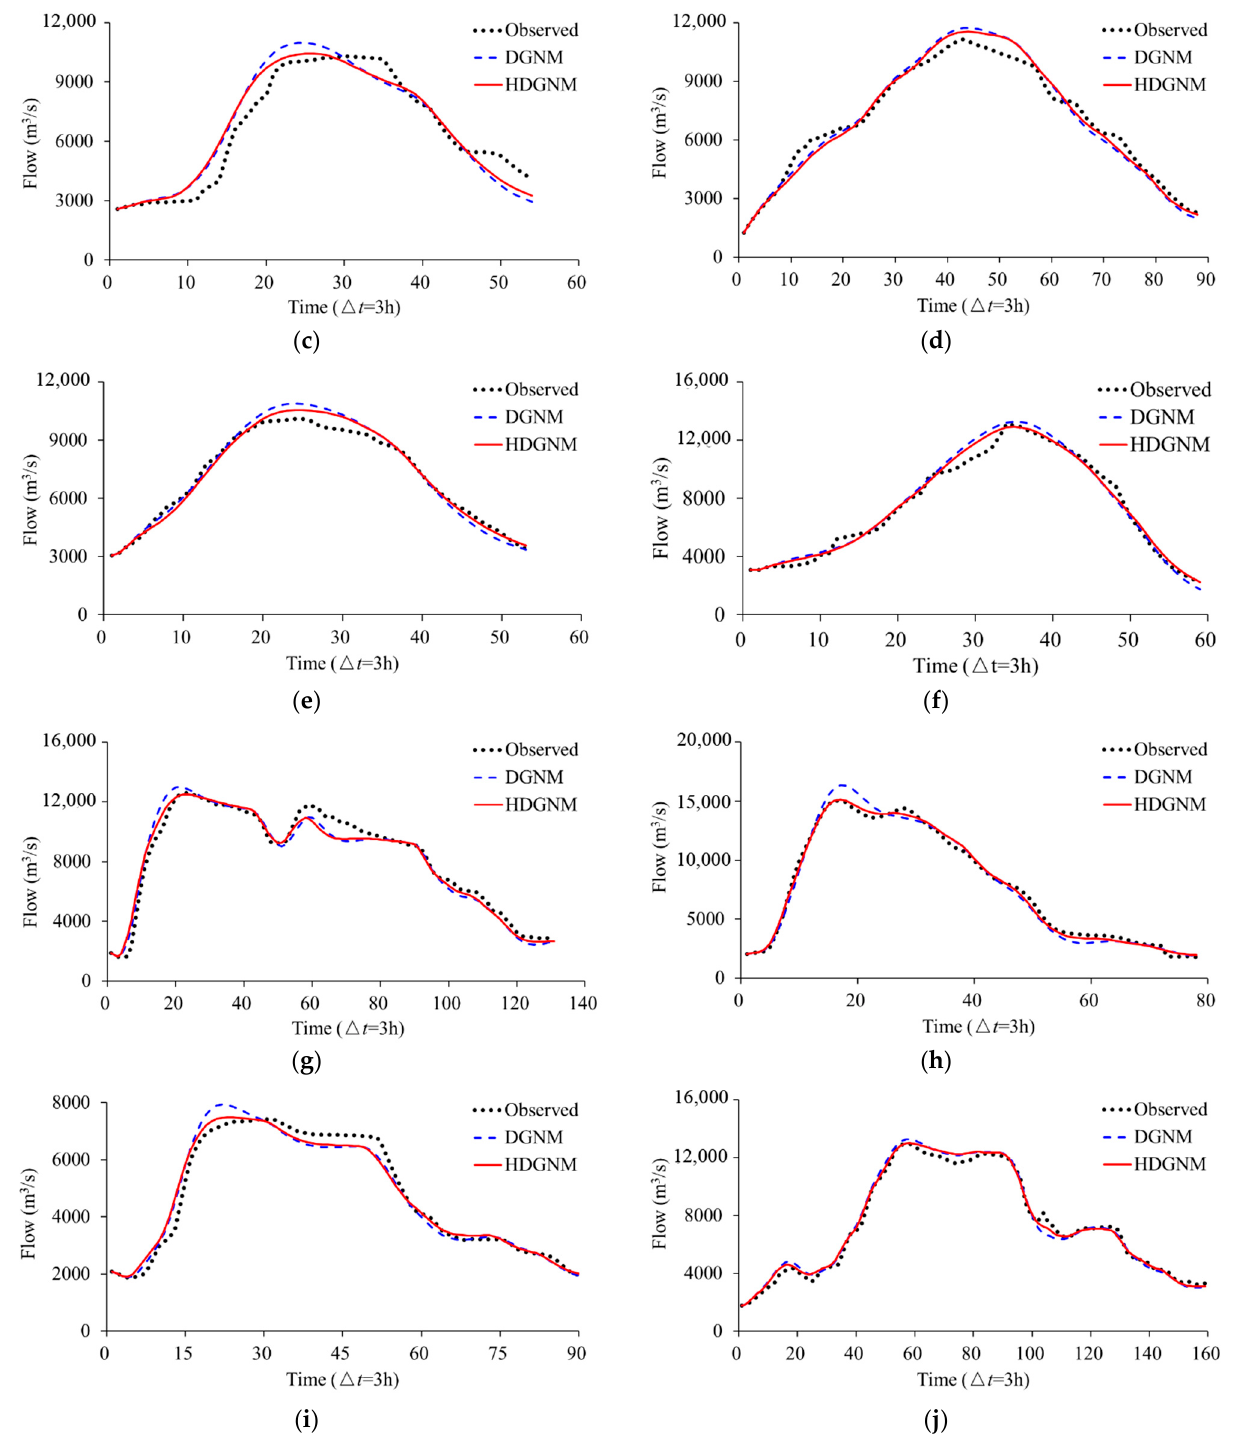
Figure 3. Comparison of computed and observed hydrographs for selected 10 floods. ( a ) Oct-1974, ( b ) Sep-1975, ( c ) Jul-1980, ( d ) Aug-1981, ( e ) Sep-1981, ( f ) Sep-1984, ( g ) Sep-2003, ( h ) Oct-2005, ( i ) Jul-2007, and ( j ) Sep-2011.